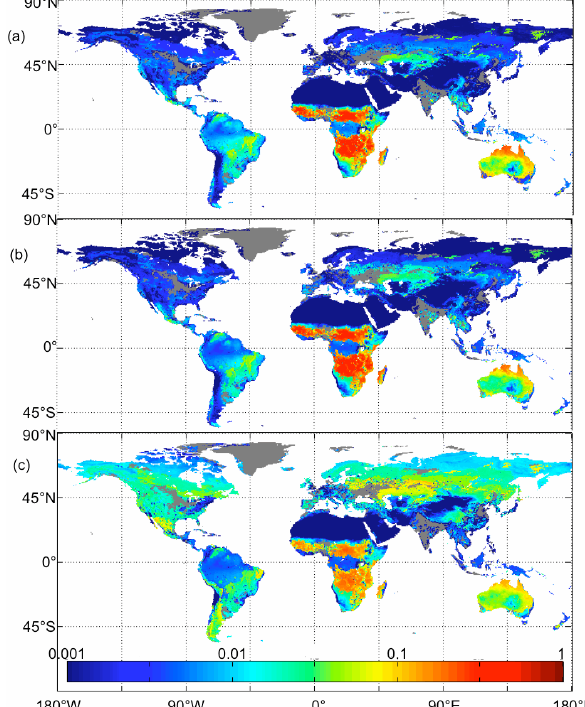
Fig. 5. Modelled mean fire frequency with parameters optimised against (a) GFED3, (b) MCD45 and (c) L3JRC observations, using 32 combined land-cover/socio-economic regions. Observed and simulated fire frequency including small fires are shown for the global case in Appendix C, Fig.